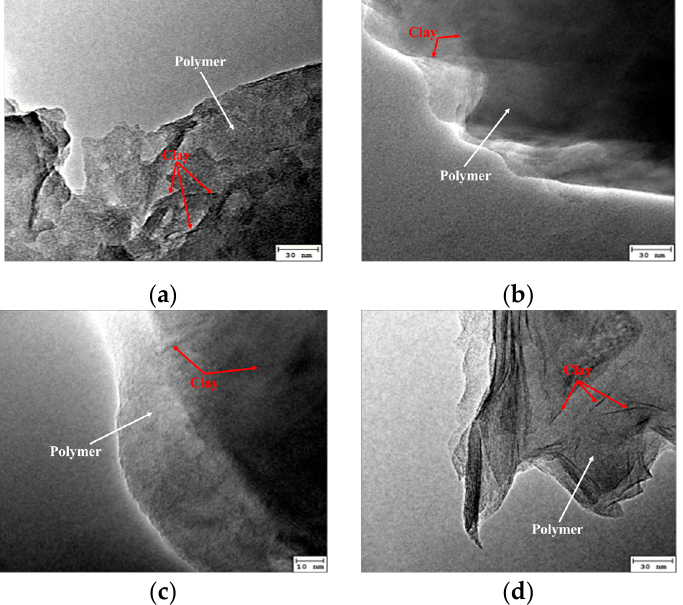
Figure 8. TEM of intercalated polymer synthesized by different concentrations of a chain extender: ( a ) 3%; ( b ) 4%; ( c ) 5%; ( d ) 6%.